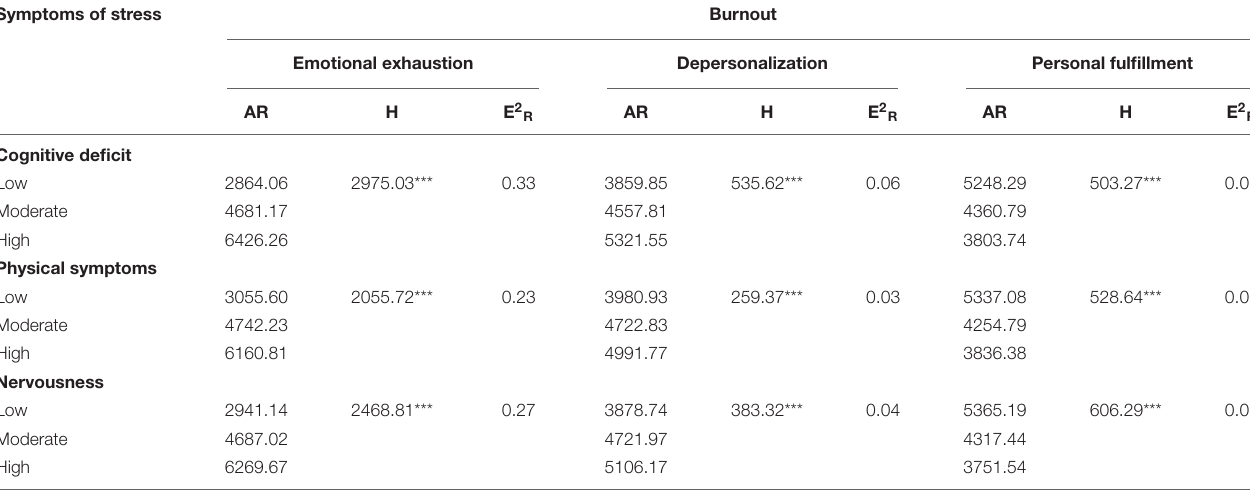
TABLE 6 | Results of the Kruskall Wallis test of variance for Burnout according to the Level of symptoms. Symptoms of stress Burnout Emotional exhaustion